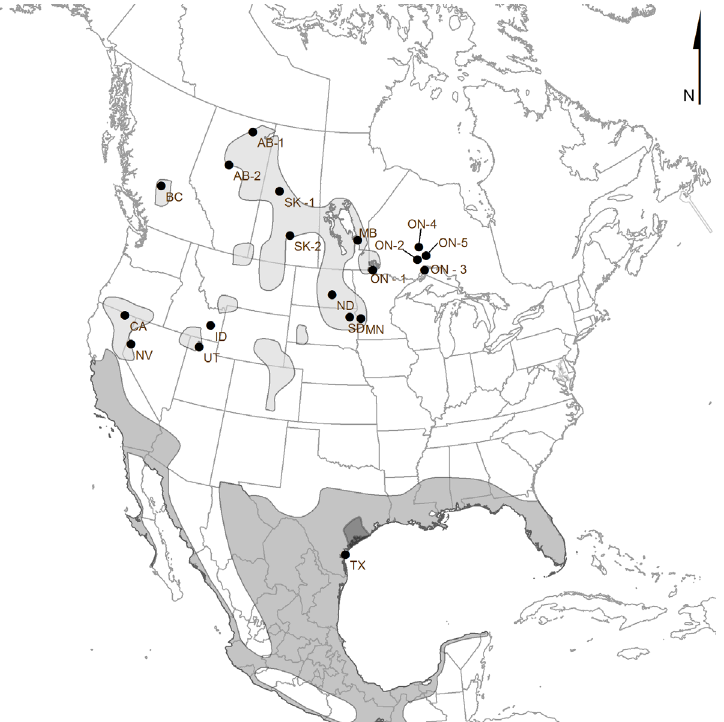
Fig 1. Map of Sampling Locations. Circles represent all sampled colonies; approximate main breeding range is shown in light gray, non-breeding range in medium gray, and year-round range in dark gray. Full colony names and location information available in S1 Table. The range map data were provided by NatureServe in collaboration with Robert Ridgely, James Zook, The Nature Conservancy, Conservation International, World Wildlife Fund, and Environment Canada